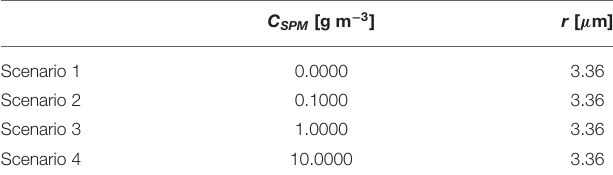
TABLE 2 | Simulated scenarios for SPM concentration variation, fixed grain